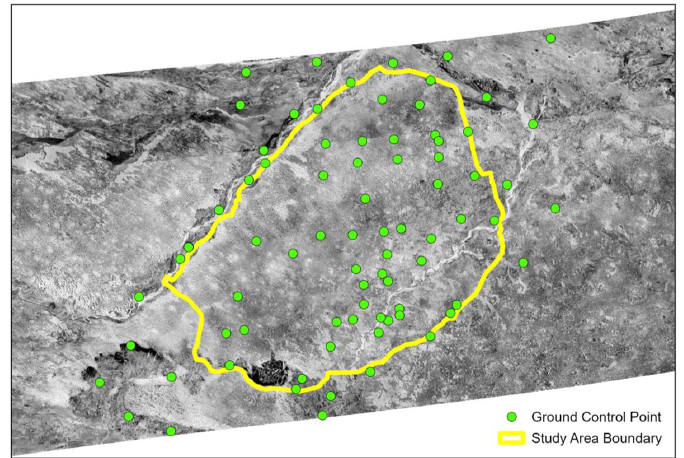
Figure 5. Location of ground control